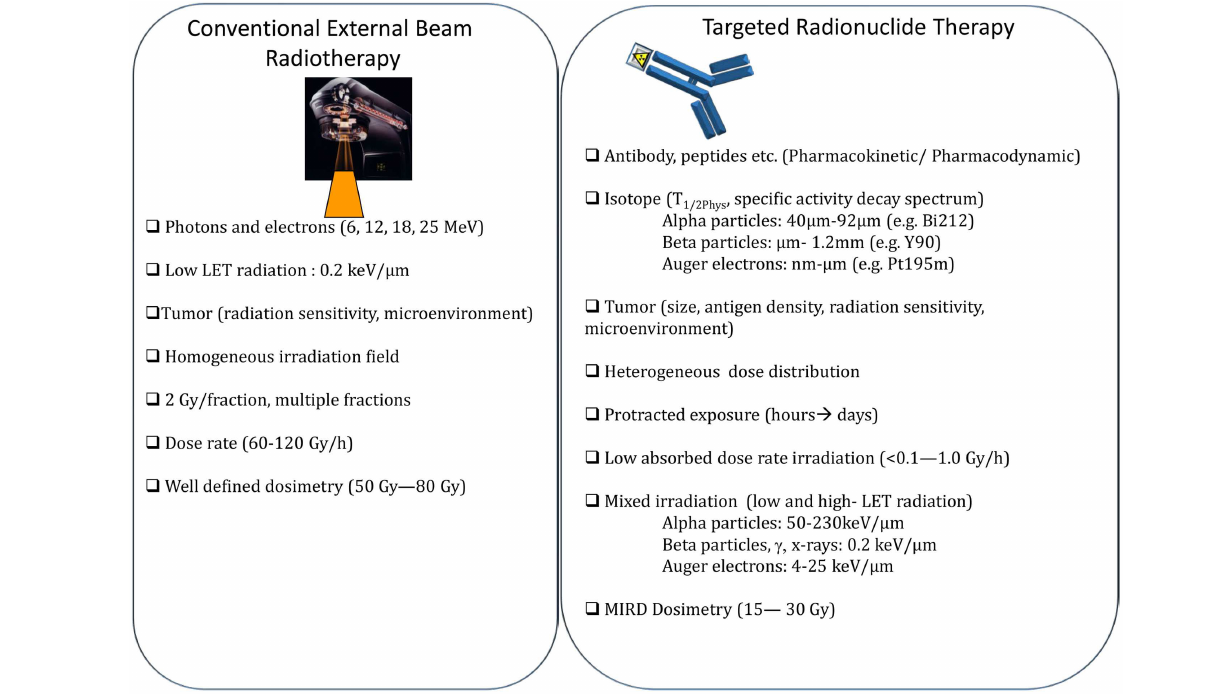
FIGURE 3 | Comparison of conventional external beam radiotherapy and targeted radionuclide therapy